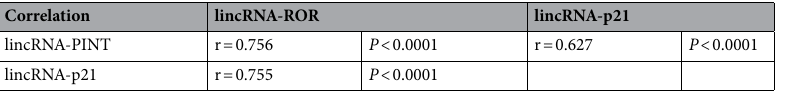
Table 4. Pairwise correlation between expression levels of lncRNAs in cases group.